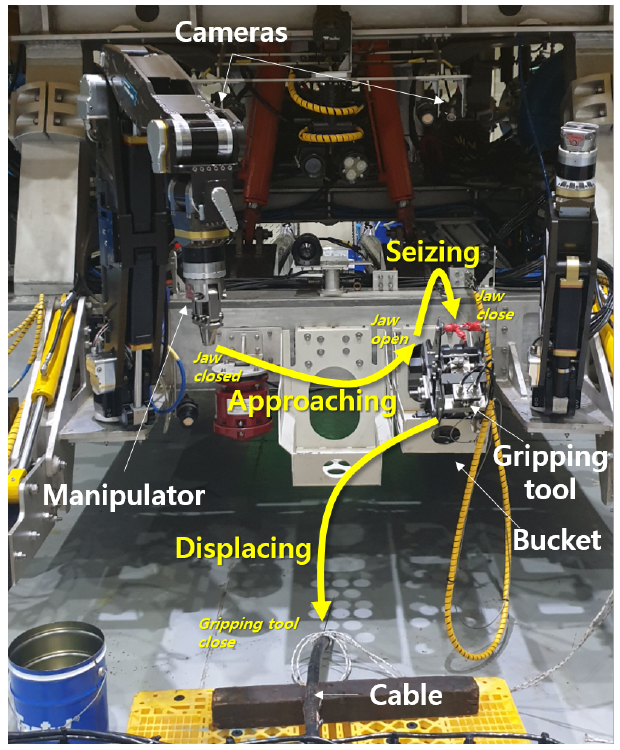
Figure 11. Experimental